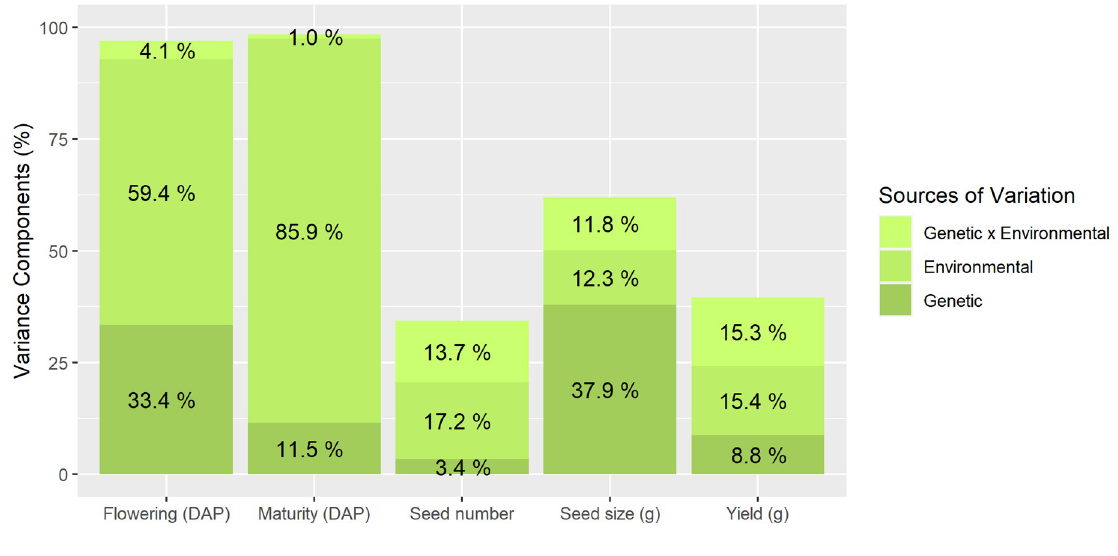
Fig 1. Estimates of genetic, environmental, and genetic-by-environmental (G x E) variance components (%) for wild soybean flowering, maturity, seed number, seed size, and yield.